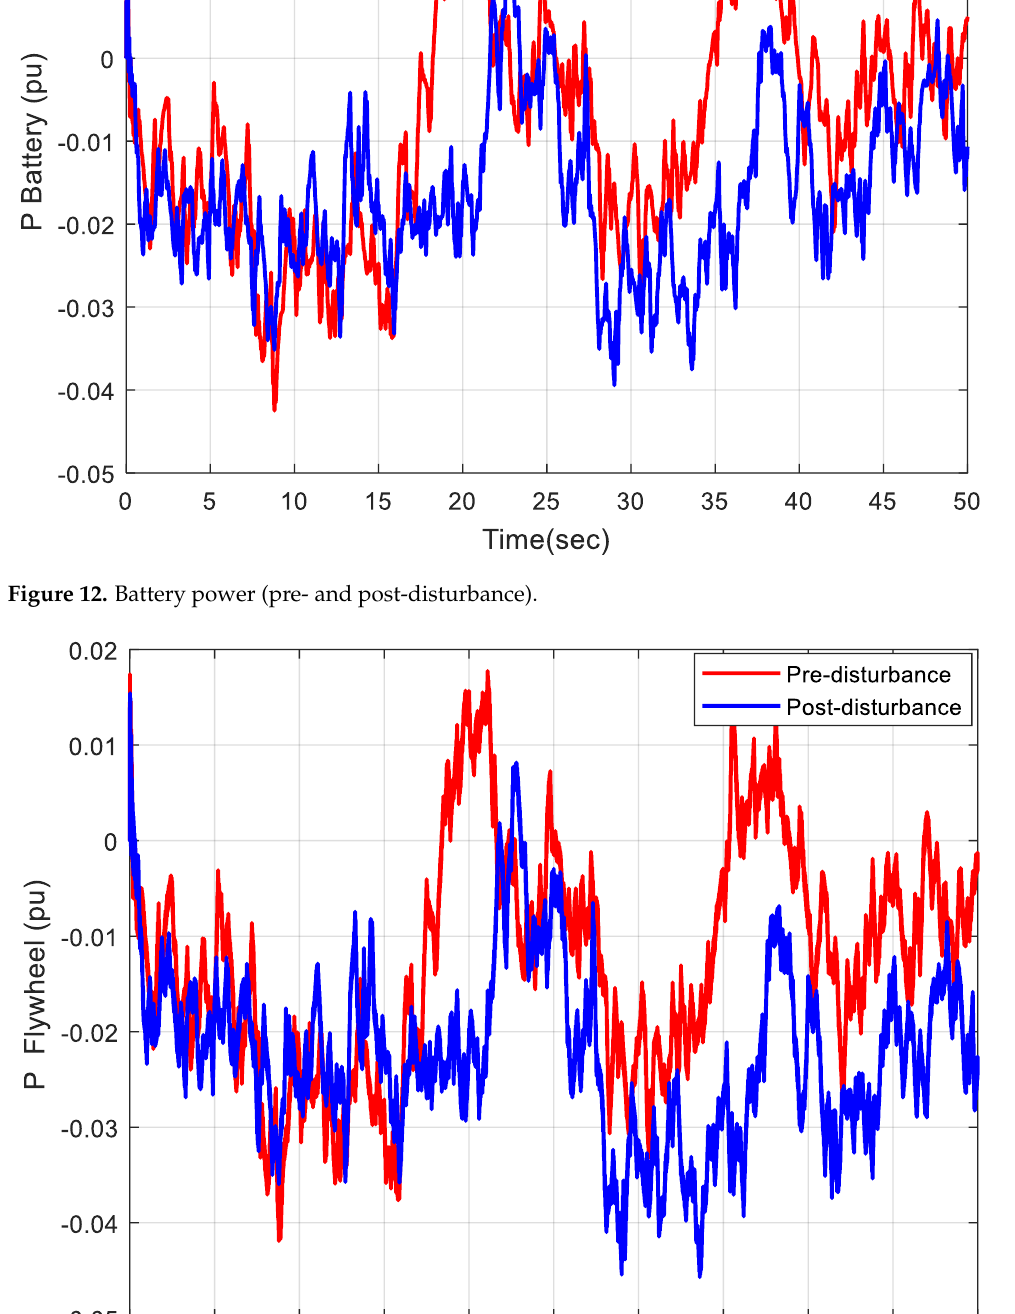
Figure 13. Flywheel power (pre- and post-disturbance).